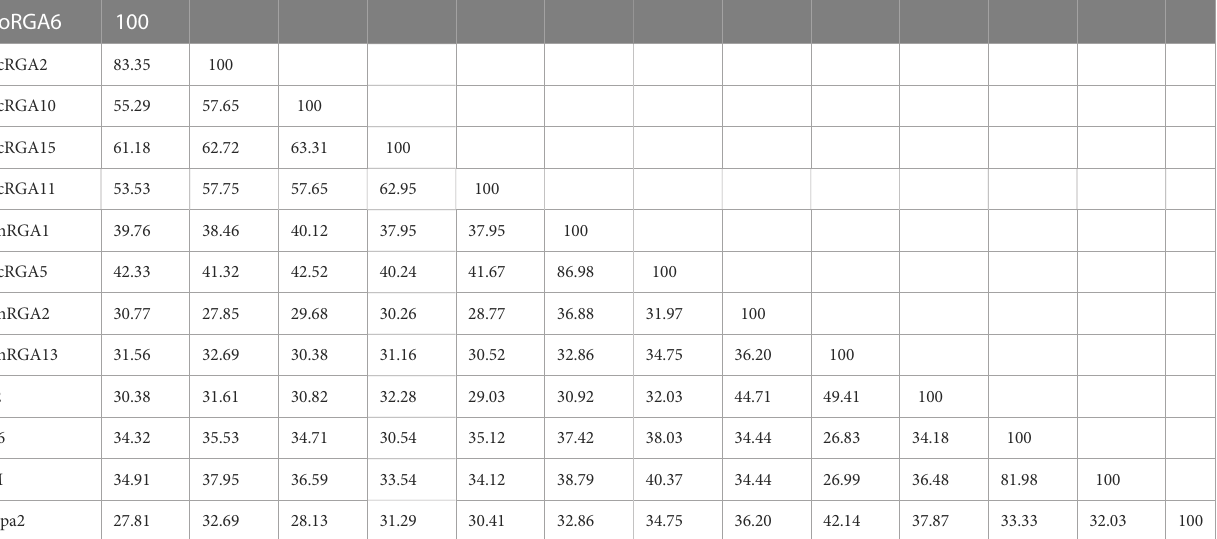
TABLE 3 Homology matrix obtained between representative lentil RGAs and known R gene using DNAMAN 8.0.